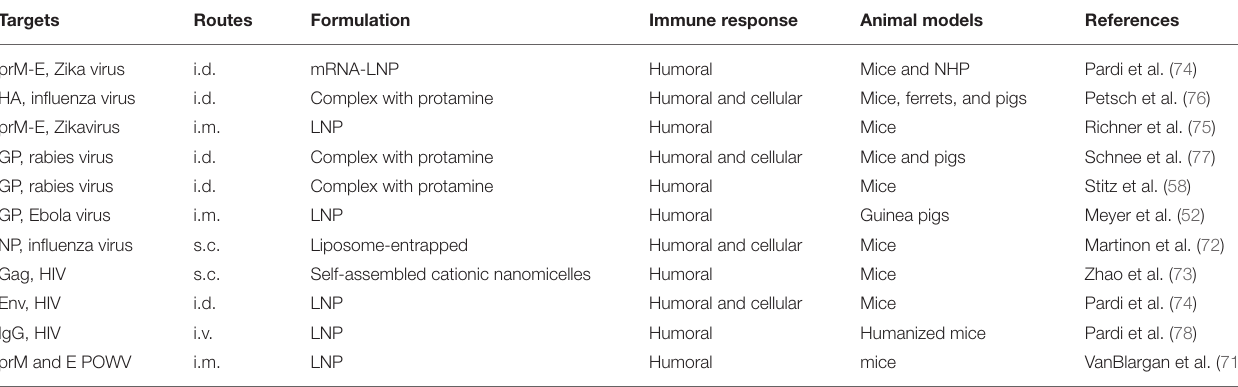
TABLE 2 | Nucleoside modified or non-modified mRNA vaccines against infectious diseases. Targets